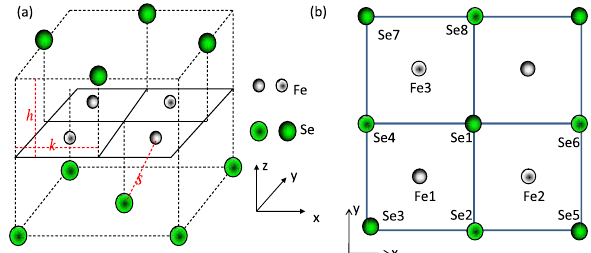
FIG. 6. The lattice structure of the FeSe trilayer is shown in (a). k is the nearest-neighbor Fe-Fe distance. h is the distance between Se and Fe layers. s is the nearest-neighbor Fe-Se distance. Panel (b) is the top view of (a), and the Fe and Se atoms are